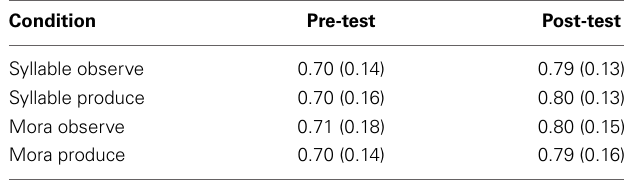
Table 3 | Pre- and post-test scores from the generalization auditory test across the four instruction